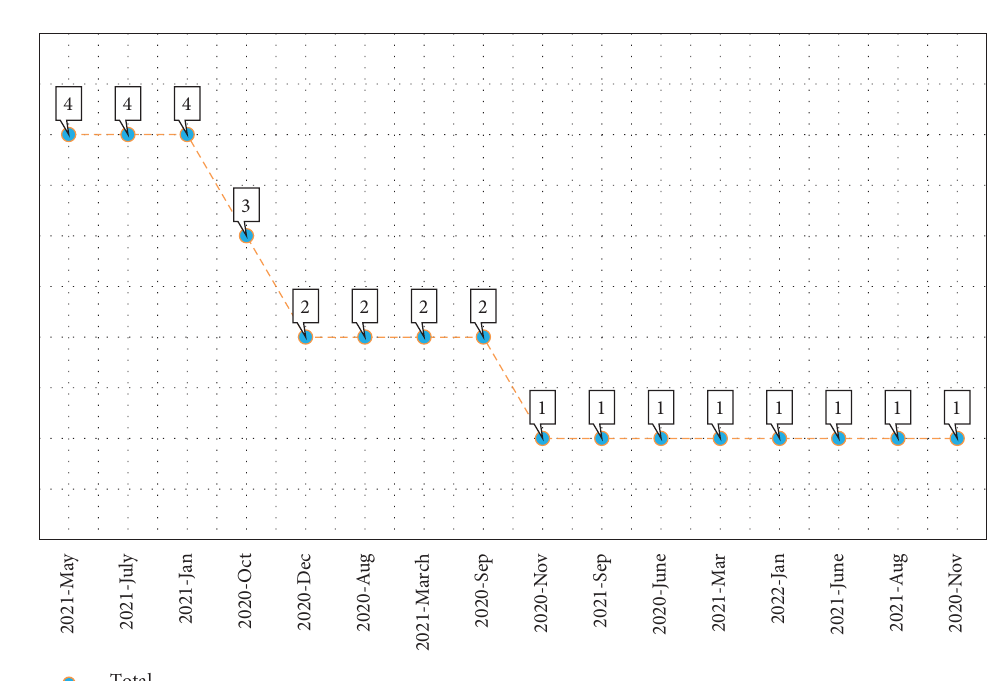
Figure 4: Te distribution of citations by publication